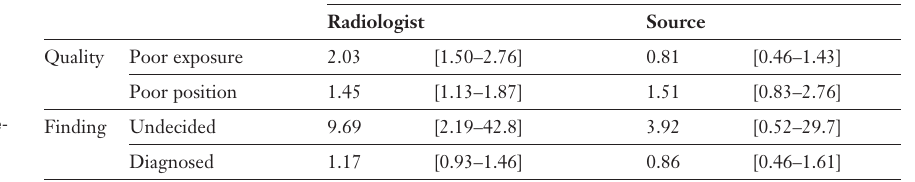
Multivariate logistic regression models for poor exposure, poor position, indecision and diag- nosis: model parame- ters are shown as odds ratios, each with a 95% confi- dence interval, and the certified labora- tory is the reference category for the source of the radi-